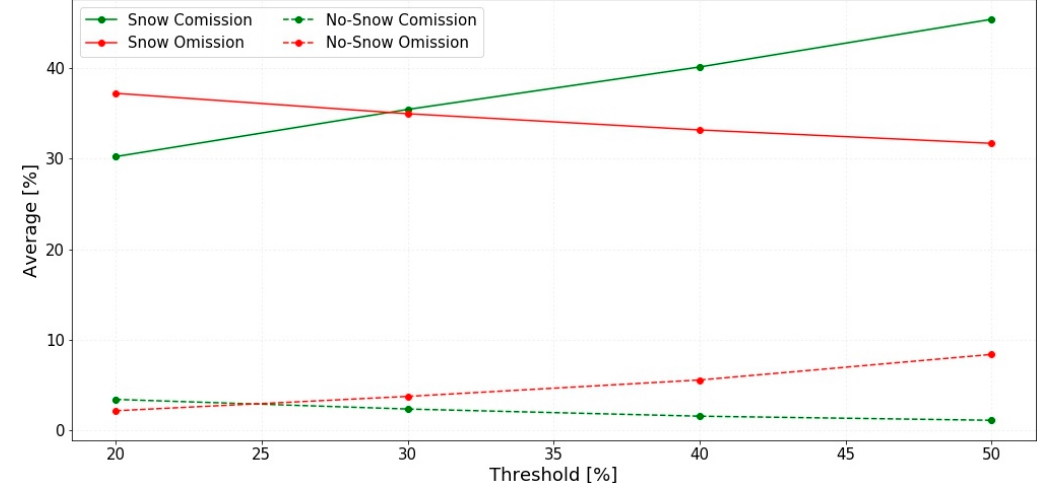
Figure 2. Line plots showing average snow and no-snow commission and omission between MODIS (reference) and VIIRS snow maps with respect to different snow cover fraction thresholds. (MODIS: Moderate Resolution Imaging Spectroradiometer; VIIRS: Visible Infrared Imaging Radiometer Suite)